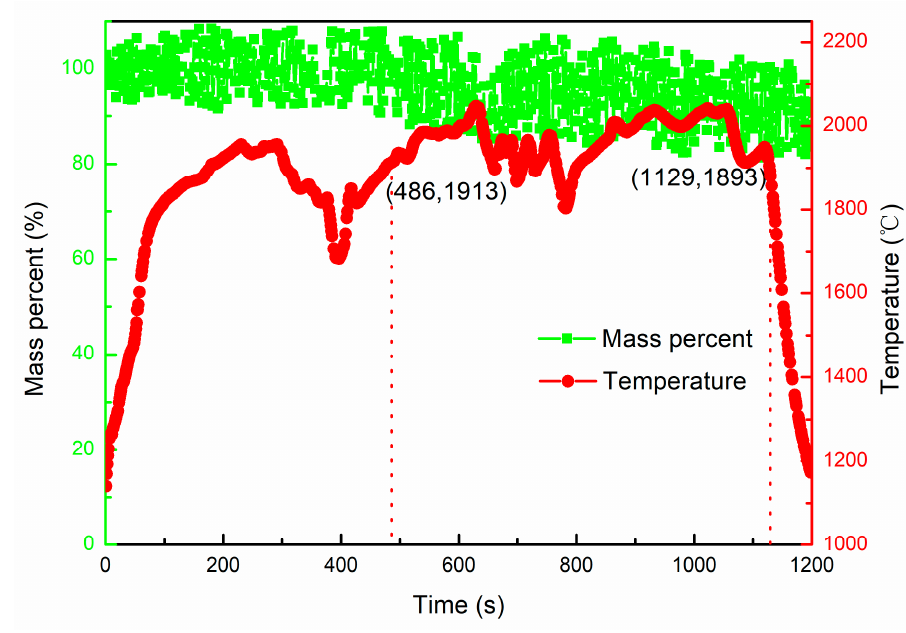
Figure 6. The vacuum evaporation of Al in V-Al alloy by EBM.